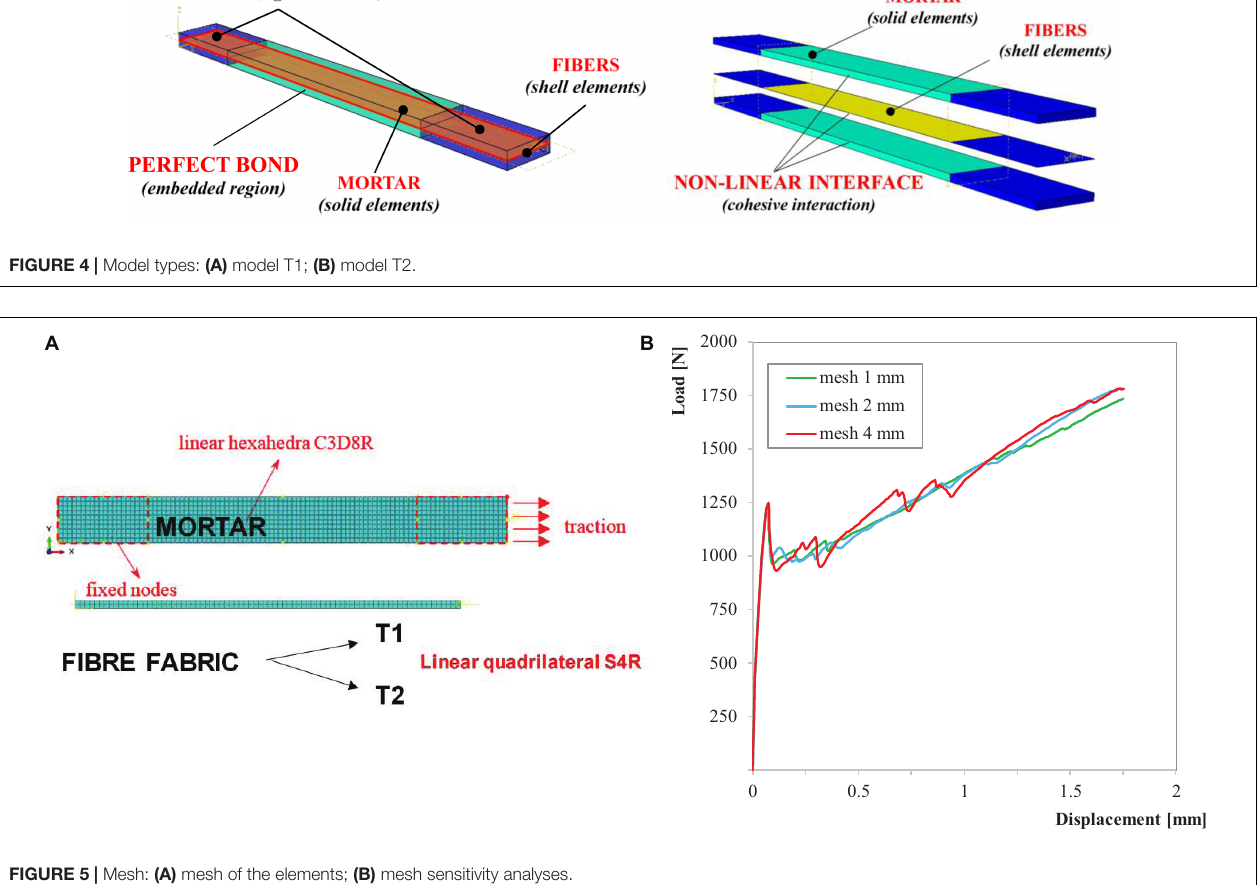
FIGURE 5 | Mesh: (A) mesh of the elements; (B) mesh sensitivity analyses.